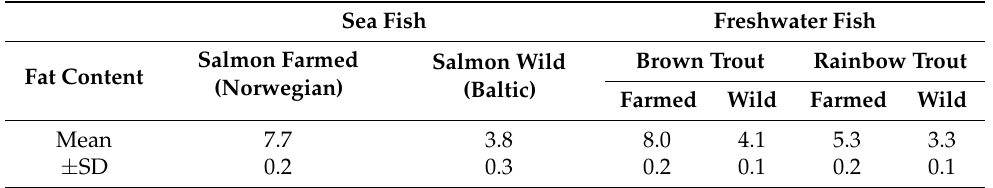
Values are expressed as mean ± standard deviation (SD) ( n = 3).